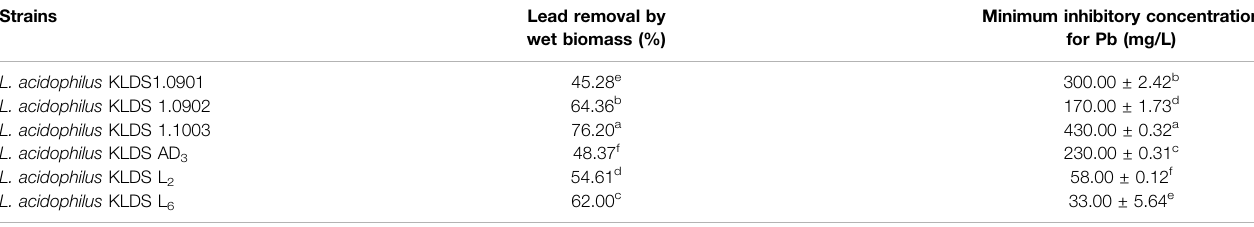
TABLE 2 | Pb tolerance and binding ability of the tested Lactobacillus acidophilus KLDS strains. Strains